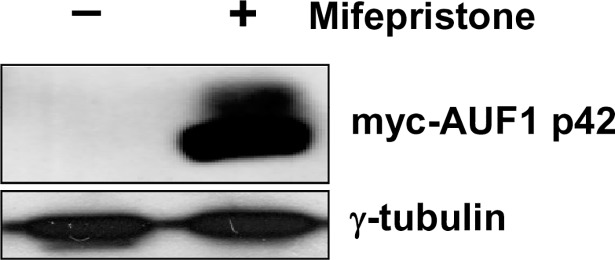
Expression of myc-AUF1 p42 in mouse 3T3 cells.Mouse 3T3 cells were stably transfected with the mifepristone-inducible vector pSLHGCMYC-AUF1 p42 [4] to express the myc-tagged AUF1 p42 isoform. The Western blot of cytoplasmic cell extracts prior (-) and after (+) 1 nM mifepristone induction was probed with anti-myc tag monoclonal antibody and anti γ-tubulin antibody.